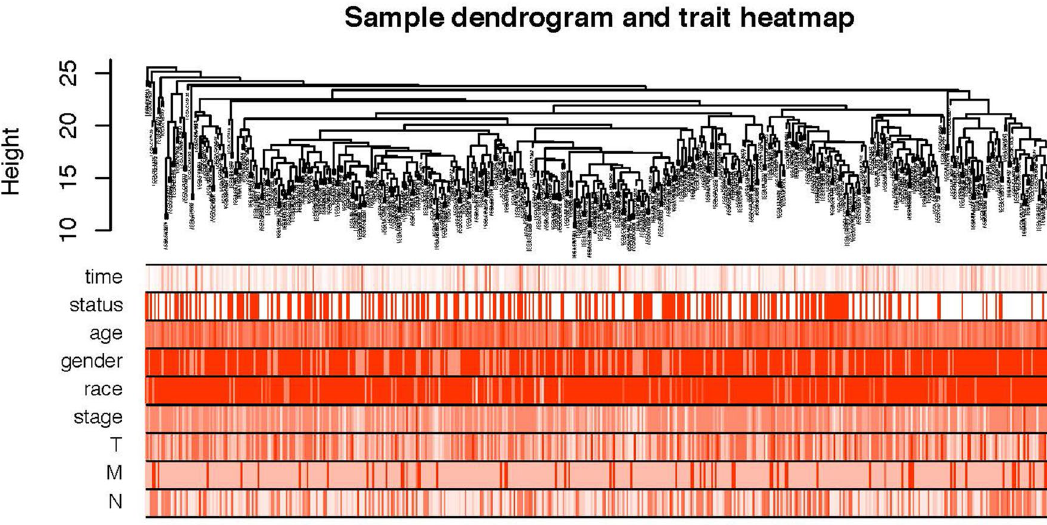
Figure 2. Clustering dendrogram of 502 HNSCC samples and the clinical traits. The red color represented death, female and metastasis. The color intensity was proportional to longer survival time, older age as well as higher tumor